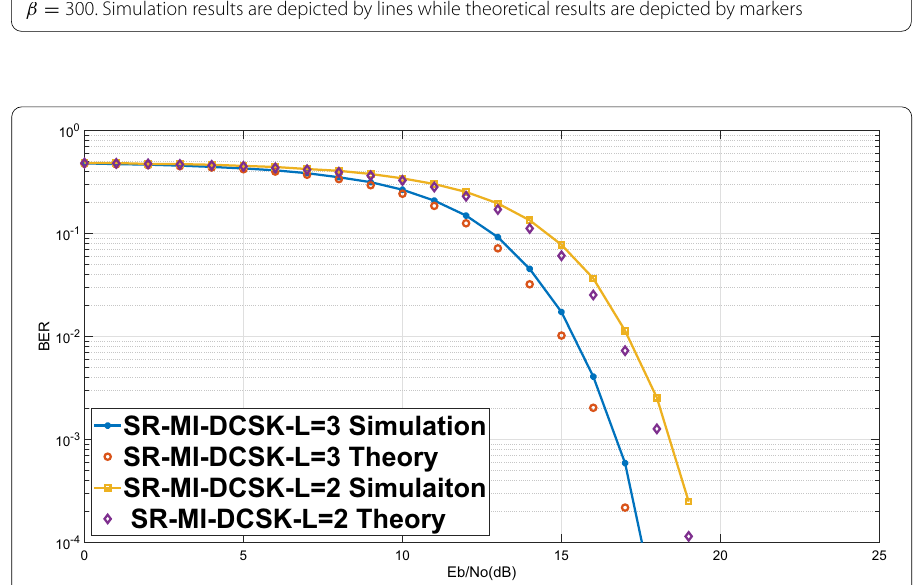
Fig. 15 Theoretical and simulation bit error performance for SR‑PI‑DCSK for different frame lengths for β = 500 . Simulation results are depicted by lines while theoretical results are depicted by